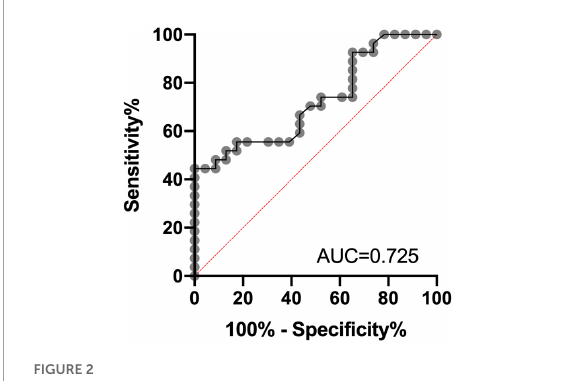
FIGURE2 Receiver operating characteristic (ROC) analysis of CyPA concentrations in plasma as a candidate biomarker of differential diagnosis for Alzheimer’s disease (AD) and subcortical ischemic vascular dementia (SIVD). AUC, area under the